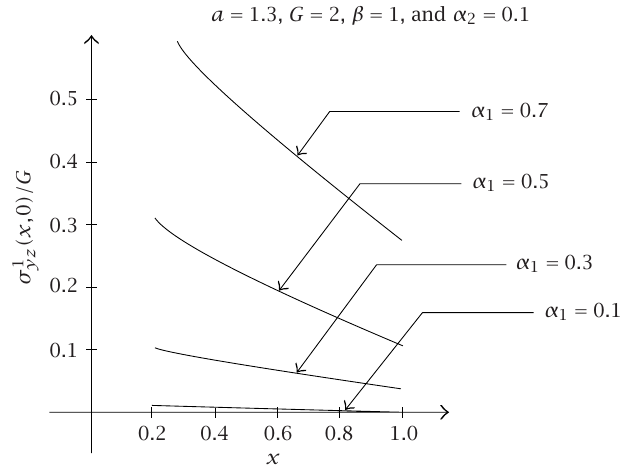
Figure 3.2 . Variation of σ 1 yz (x, 0 )/G β = − 0 . 7 , − 0 . 5 , − 0 . 3 , 0 . 1 , 0 . 5 , 0 . 7, a = 1 . 3, G = 2, α 0 . 1.